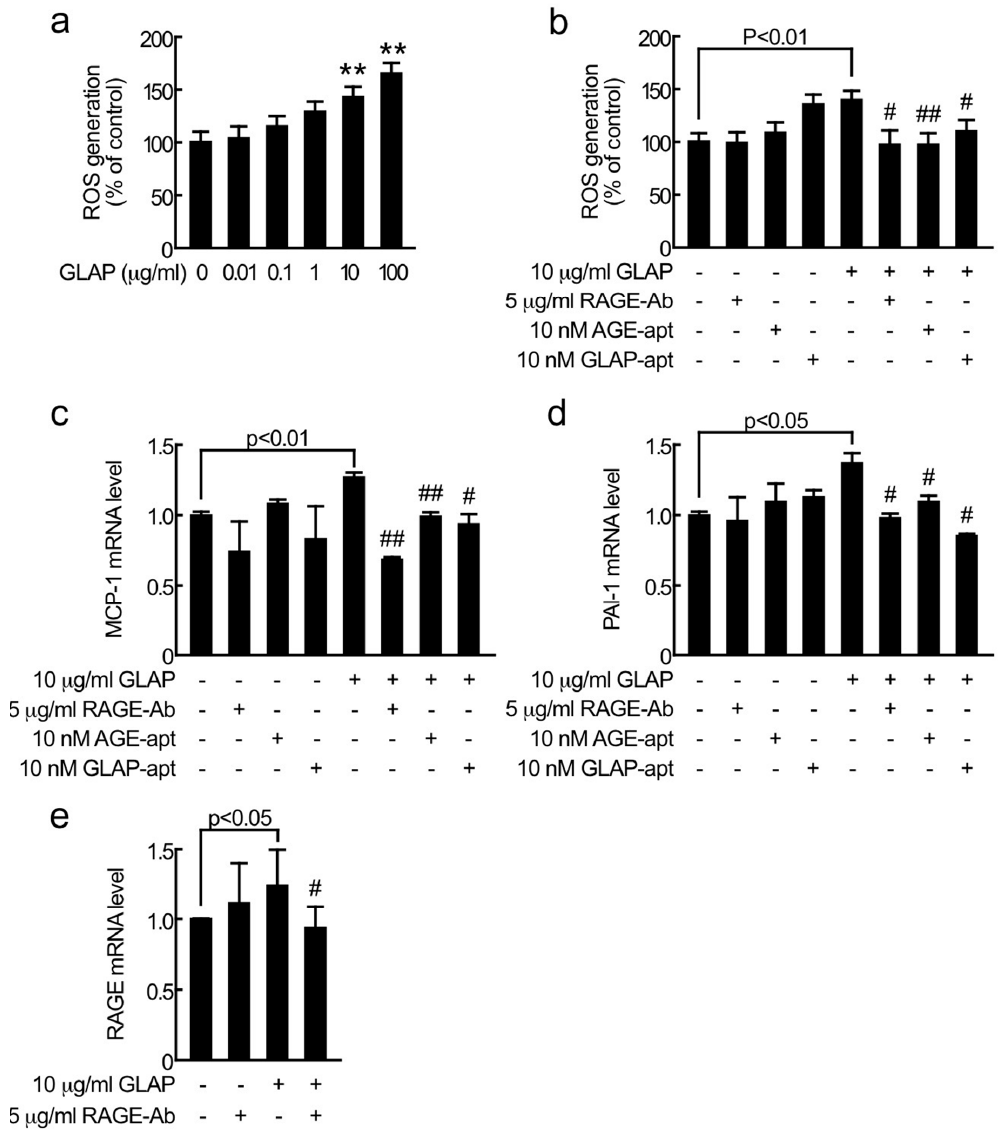
Figure 2. E ff ects of glyceraldehyde-derived pyridinium (GLAP) or GLAP-aptamer (GLAP-apt) on ROS generation ( a , b ), MCP-1 ( c ), PAI-1 ( d ), and RAGE mRNA levels ( e ) in proximal tubular cells. Tubular cells were treated with the indicated concentrations of GLAP in the presence or absence of 5 µ g / mL RAGE-Ab, 10 nM AGE-apatmer (AGE-apt), or 10nM GLAP-apt for 1 h ( a , b ) or for 4 h ( c – e ). ROS generation was evaluated by CellRox oxidative stress reagents. N = 6 per group ( c – e ). Total RNAs were transcribed and amplified by real-time PCR. Data were normalized by the intensity of 18S rRNA mRNA-derived signals and then related to the control values. ( c , d ) N = 3 per group. ( e ) N = 7 per group. **, p < 0.01 compared to the control values. # and ##, p < 0.05 and p < 0.01 compared to the values with 10 µ g / mL GLAP alone,